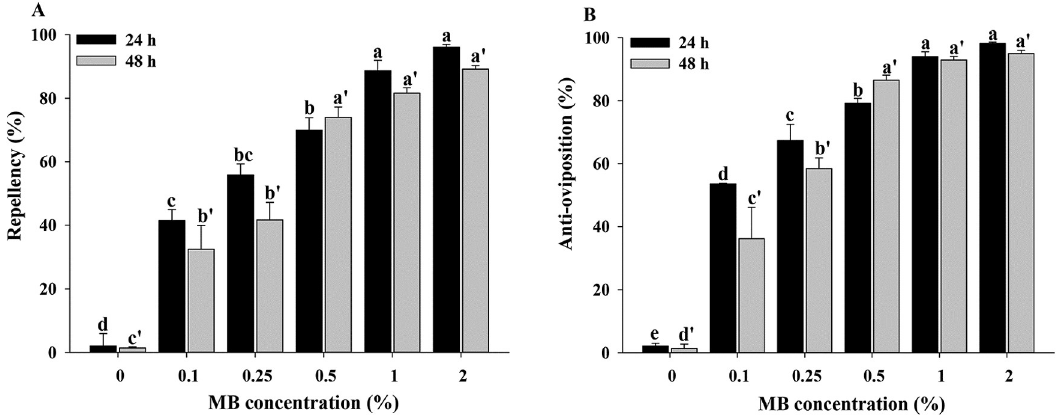
Fig 6. Repellency and anti-oviposition activity of tomato plants sprayed with methyl benzoate. Tomato plants were treated with 0%, 0.1%, 0.25%, 0.5%, 1%, and 2% MB solutions. One non-treated and one treated tomato plant were placed together within a single cage before releasing 100 adults of B . tabaci . Repellency was determined through counting B . tabaci on leaves (n = 100) of both plants at 24 and 48 h post-treatment. Eggs on leaves (n = 10) of each plant were counted at 24 and 48 h post-treatment to determine anti-oviposition activity. Values are means of three replications. For (A) repellency, means marked with different superscript letters are significantly different at α = 0.05 ( N = 3, df = 5, 17; for 24 h, F = 108.56; P < 0.0001; for 48 h, F = 68.20; P < 0.0001). For (B) anti- oviposition, means followed by different superscript letters are significantly different at α = 0.05 ( N = 3, df = 5, 17; for 24 h, F = 231.17; P < 0.0001; for 48 h, F = 71.77; P < 0.0001).